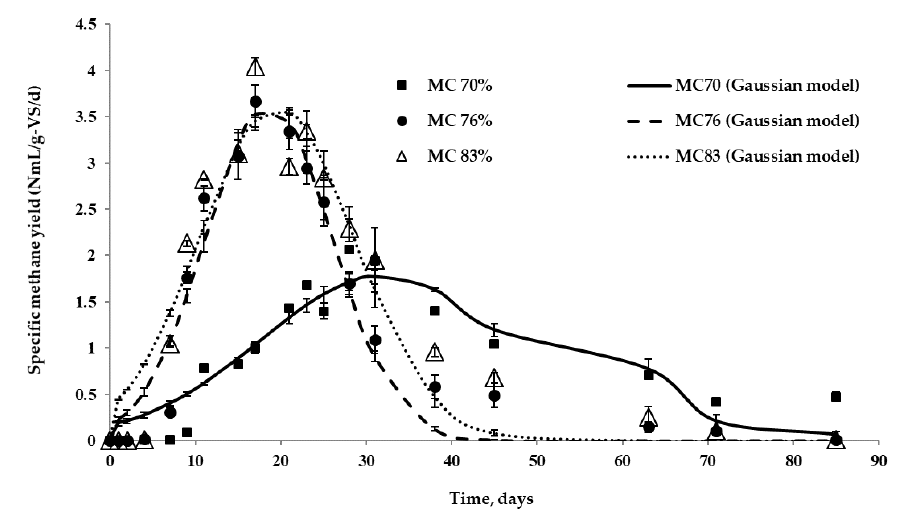
Figure 3. Influence of initial feedstock moisture content on specific methane yields from dairy manure. Digesters containing non-amended manure containing 70% MC (MC70) and manure amended to 76% and 83% MC (equivalent to the water holding capacity of dairy manure) (MC76 and MC83, respectively) were incubated at 37 ° C for 85 days. Values are means (± SE) of three replicates. Experimental and model-derived results are shown.